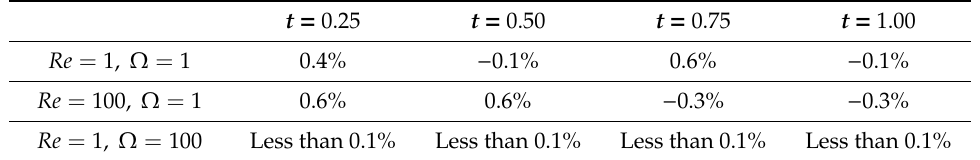
Table 2. Wall shear stress percentage error ( 𝑛 = 0.5 , 𝜀 = 0.1 